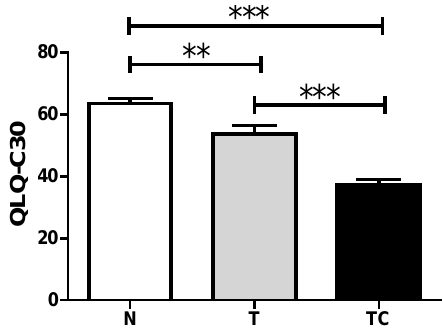
Figure 1. Serum Hemoglobin ( A ) C-Reactive Protein ( B ) and Albumin ( C ) concentration. Data expressed as mean ± standard error; *: p < 0.05; ***: p < 0.001.